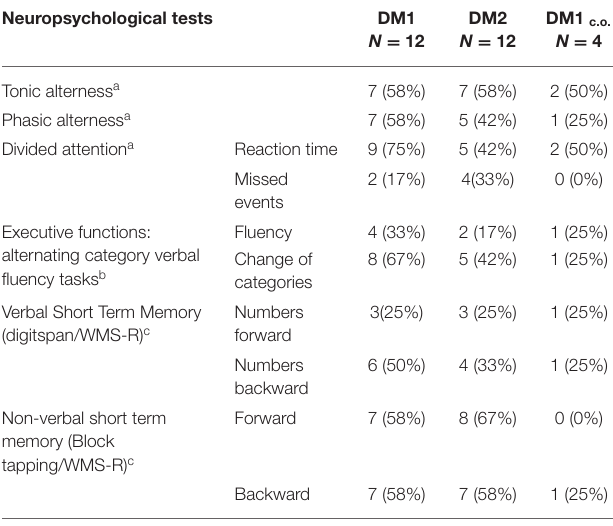
TABLE 2 | Neuropsychological test results for DM1, DM2, and DM1 c.o. : number and percentage of patients with abnormal test results if at least 25% within one subgroup were